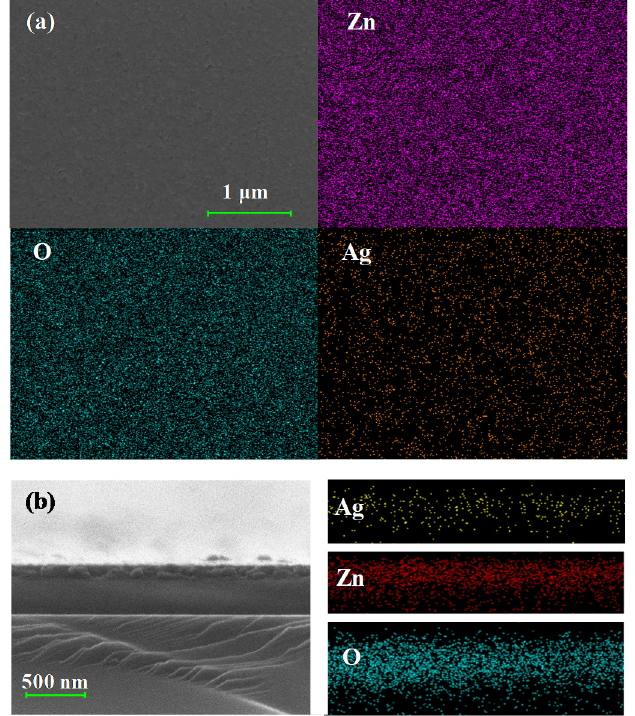
Figure 6. The EDS analysis of ZnO/Ag (5 nm) films: ( a ) the horizontal surface; ( b ) the cross-section.